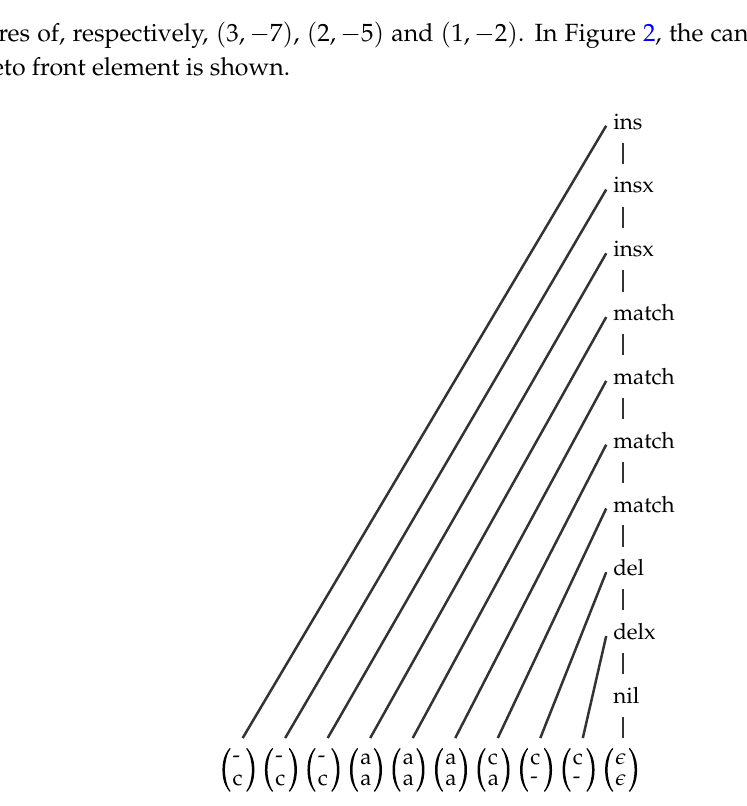
Figure 2. Example of a candidate